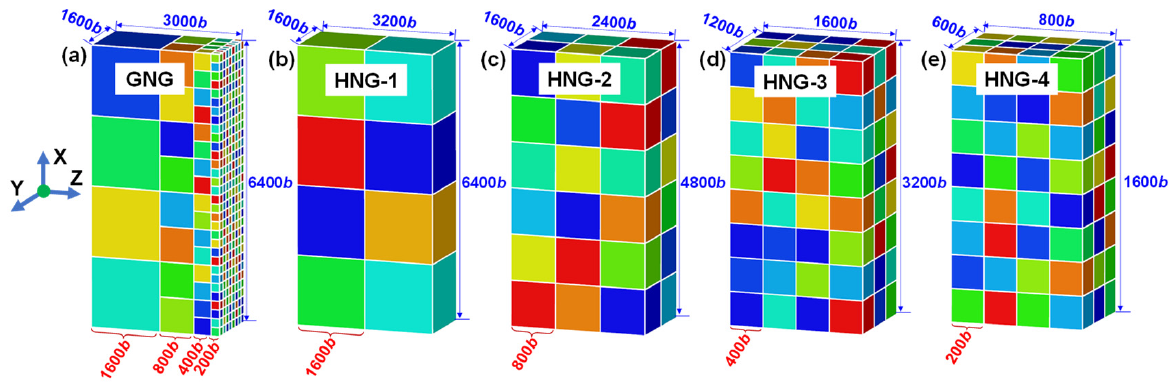
Figure 1. Geometries and sizes of ( a ) gradient nano-grained (GNG) sample and ( b – e ) four corre- sponding homogeneous nano-grained (HNG) counterparts: HNG-1, HNG-2, HNG-3 and HNG-4.